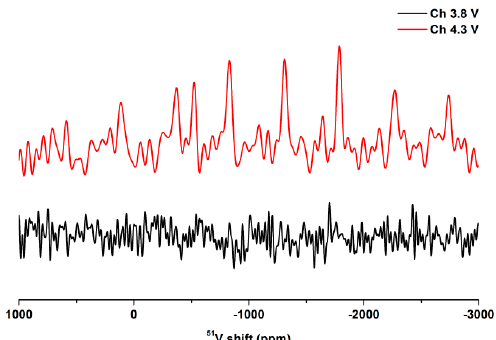
Figure 5. Ex situ 51 V solid-state NMR (ssNMR) of Na 3 V(PO 4 ) 2 charged to different voltages in the first cycle.